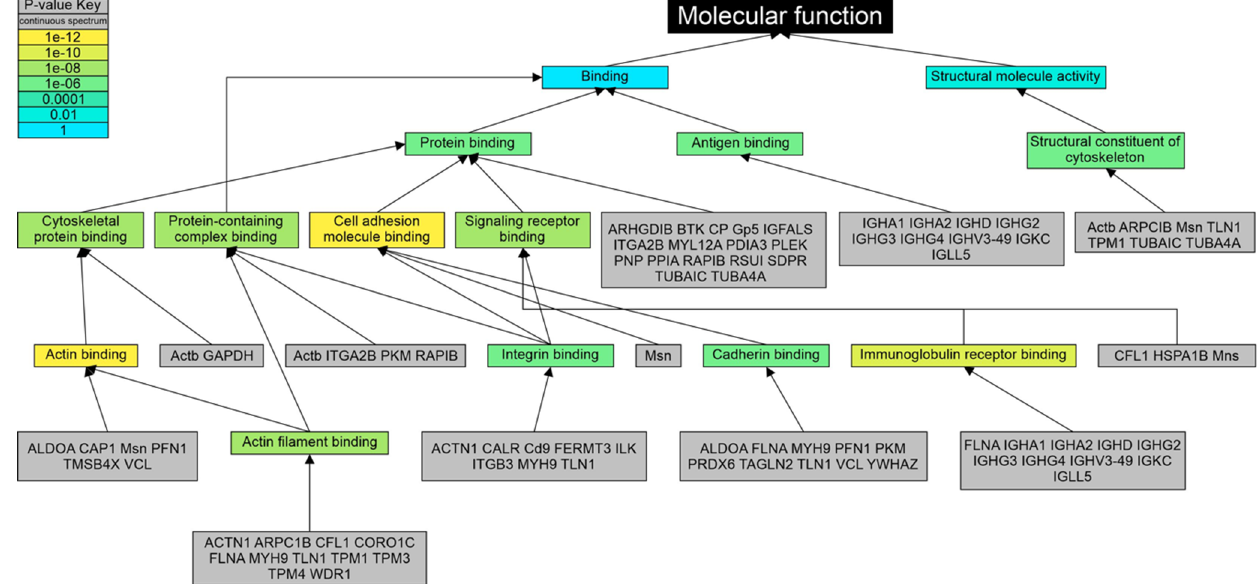
Figure 5. Gene ontology analysis of 59 downregulated proteins using molecular function as classificatory term. The list of 59 downregulated proteins was used as input in the LAGO tool. In the analysis, human GOA option, molecular function, p -value cutoff of 0.001, and Bonferroni correction, were selected. The background size shown in the Figure was of 19,680. Actin binding ( p = 6.82 × 10 –13 ), cell adhesion molecule binding ( p = 6.08 × 10 –12 ), and immunoglobulin receptor binding ( p = 3.5 × 10 –11 ) were the terms with more significant p -values. Protein binding (GO: 0005515) grouped all the proteins included in the analysis ( p = 1.37 × 10 –5 ).